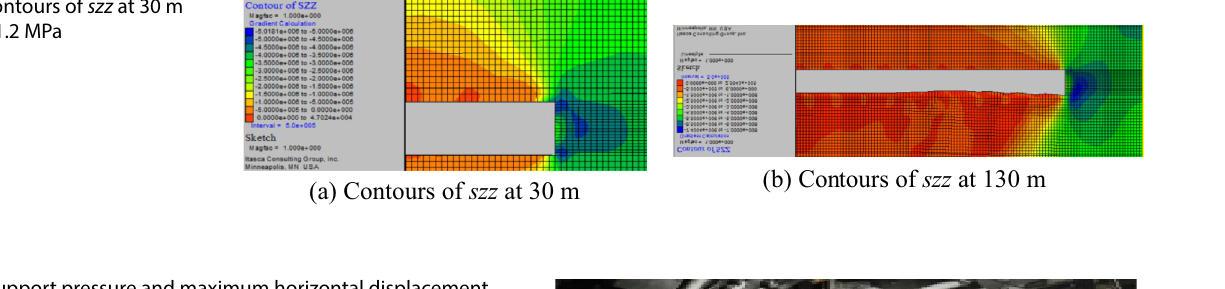
Table 3 Support pressure and maximum horizontal displacement Support pressure/MPa